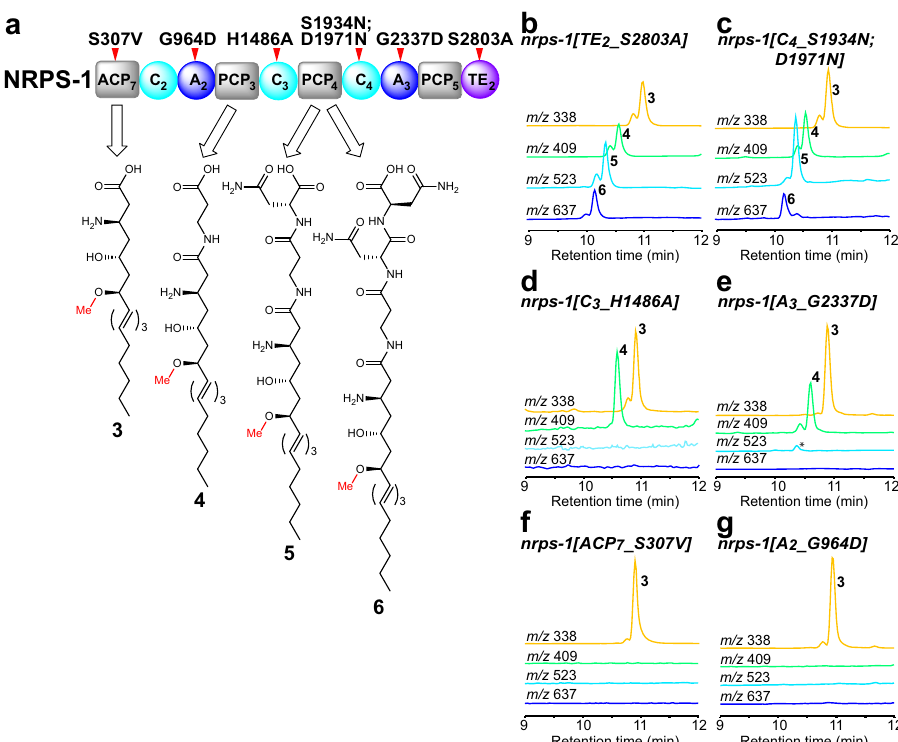
Fig. 2 Analysis of biosynthetic intermediates in mutant strains in which speci fi c NRPS-1 domains have been inactivated. a The structures of the intermediates that were identi fi ed in the NRPS-1 mutant strains and the proposed carrier proteins that carry them as the corresponding thioesters. Domain abbreviations: acyl carrier protein (ACP), peptidyl carrier protein (PCP), adenylation (A), condensation (C), thioesterase (TE). The domains that were mutated are indicated with a red tick mark. The chemical structures of the intermediates were con fi rmed through high resolution LC – MS/MS (Supplementary Figs. 4 – 7). b – g Representative extracted ion chromatograms of intermediates 3 ([M-H] − m/z 338), 4 ([M-H] − m/z 409), 5 ([M-H] − m/z 523), and 6 ([M-H] − m/z 637) in the NRPS-1 TE 2 domain mutant nrps-1(reb12[TE 2 _S2803A]) ( b ), the NRPS-1 C 4 domain mutant, nrps-1(gk186409 [C 4 _S1934N];gk186410[C 4_ D1971N]) ( c ), the NRPS-1 C 3 domain mutant, nrps-1(reb10[C 3 _H1486A]) ( d ), the NRPS-1 A 3 domain mutant, nrps-1(reb31 that the NRPS-1 C 4 domain mutant contains a mutation near the active site (S1934N), as well as one more distal to the active site (D1971N). In ( e ), the asterisk (*) indicates that a very small amount of 5 is seen in this mutant (see Supplementary Fig. 3 for quantitative analysis of intermediates), likely because the mutation in the nrps-1(reb31[A 3 _G2337D]) strain does not appear to completely block domain function as this strain can make a small amount of nemamides (see Supplementary Fig.